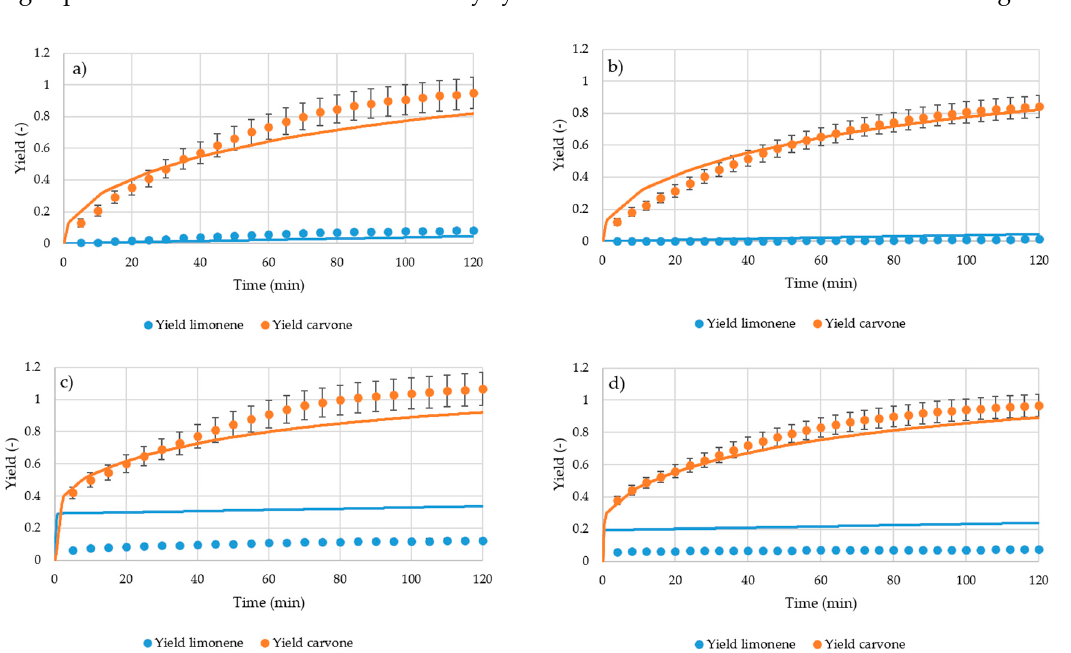
Figure 16. Corner points of the experimental design for caraway system. ( a ): 1 mL / min / 0%; ( b ): 7 mL / min / 0%; ( c ): 1 mL / min / 100%; ( d ): 1 mL / min / 100%.